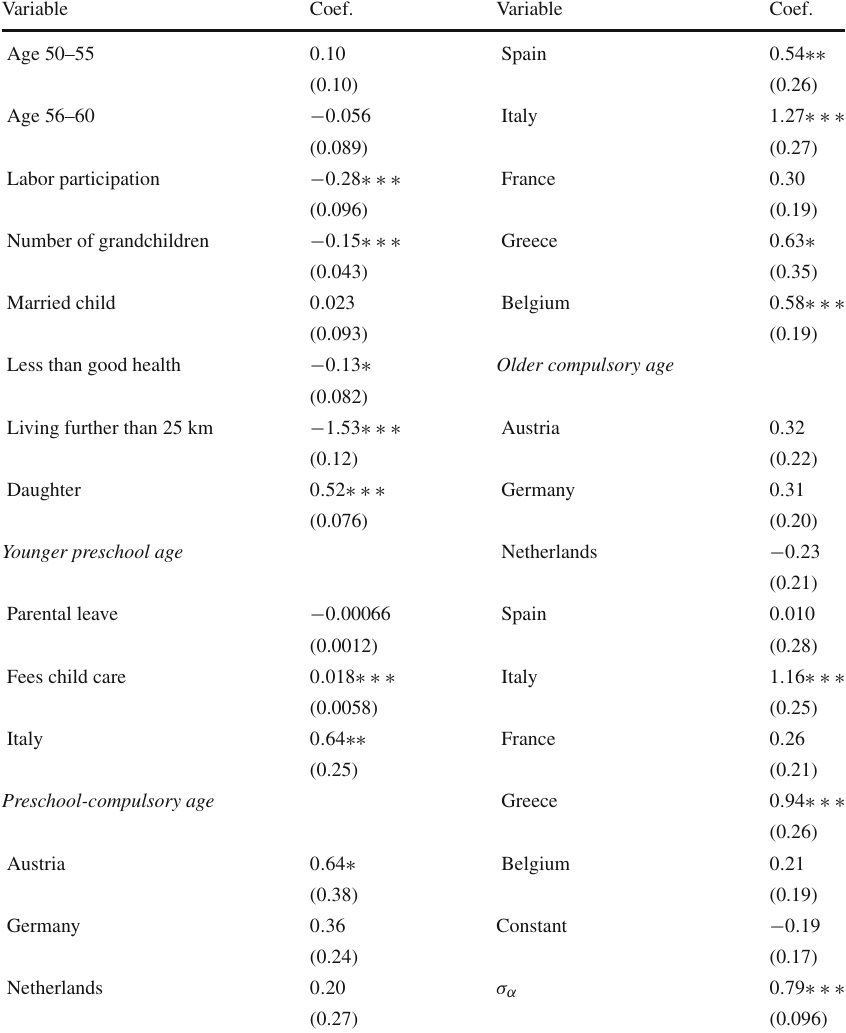
Table 9 Random effect probit estimates of the caregiving decision Variable Coef.